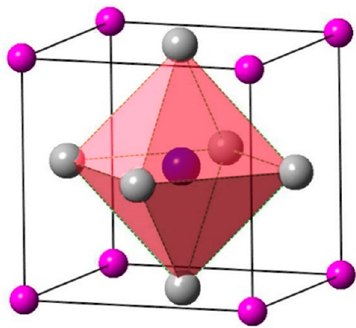
Figure 1. The anti-perovskite structure of Ti 3 AN with diagram of octahedron in which the Ti atoms located.